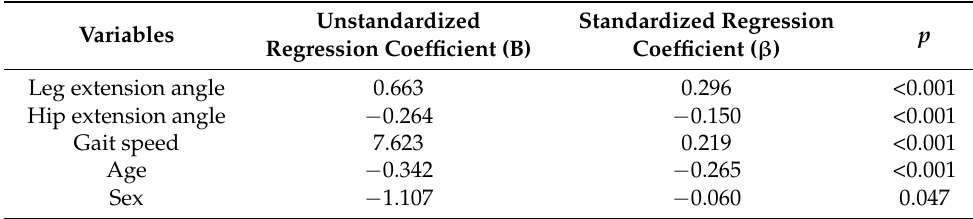
Table 2. Multiple regression analysis of knee flexion angle at mid-swing and gait parameters at late